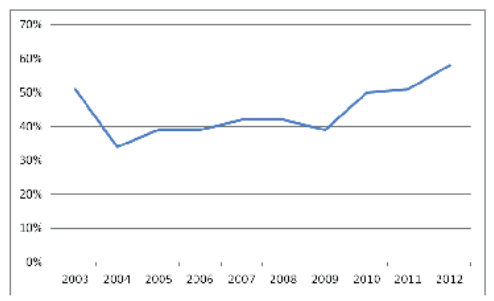
Figure 2 - Percentages of the total score of the CONSORT recom- mendations met by year of publication (2003 - 2012). The percent- age was calculated over 29 items and not the 37 of CONSORT, be- cause they were removed 8 items that are optional. Seventy-eight studies were